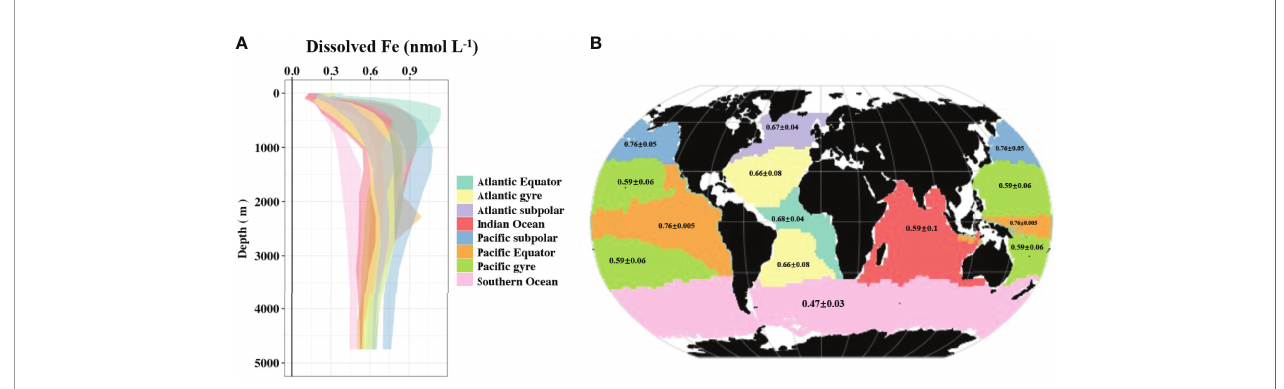
FIGURE 8 | Mean pro fi le of dissolved Fe (dFe) with the shading representing the standard deviation (A) , and mean dFe concentration (±standard deviation) at the depth between 3000 m and 3500 m (B) in the main ocean